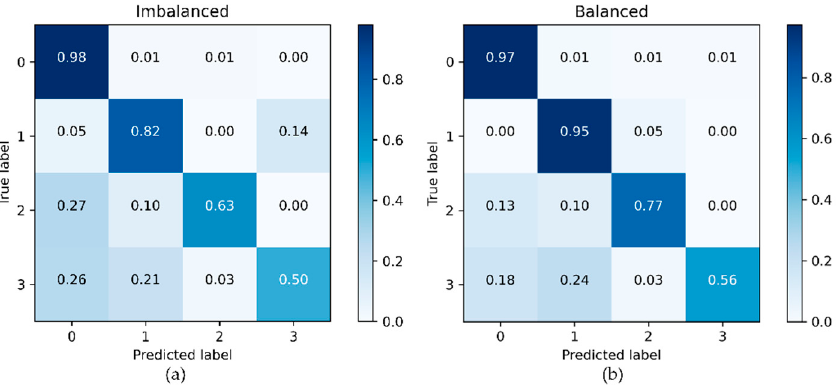
Figure 14. Confusion matrices for road surface assessment with the base classifier trained on ( a ) the original (imbalanced) set and ( b ) the original data augmented with the Unrolled GAN.